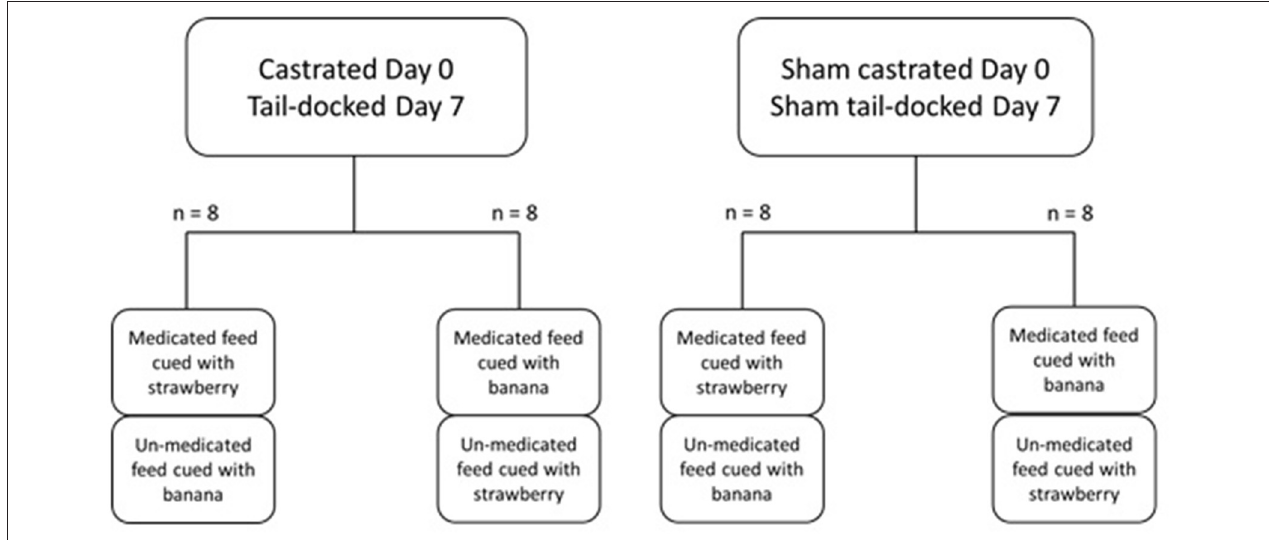
FIGURE 1 | Diagrammatic representation of the experimental design indicating the allocation of groups and sub-groups during the experiment.